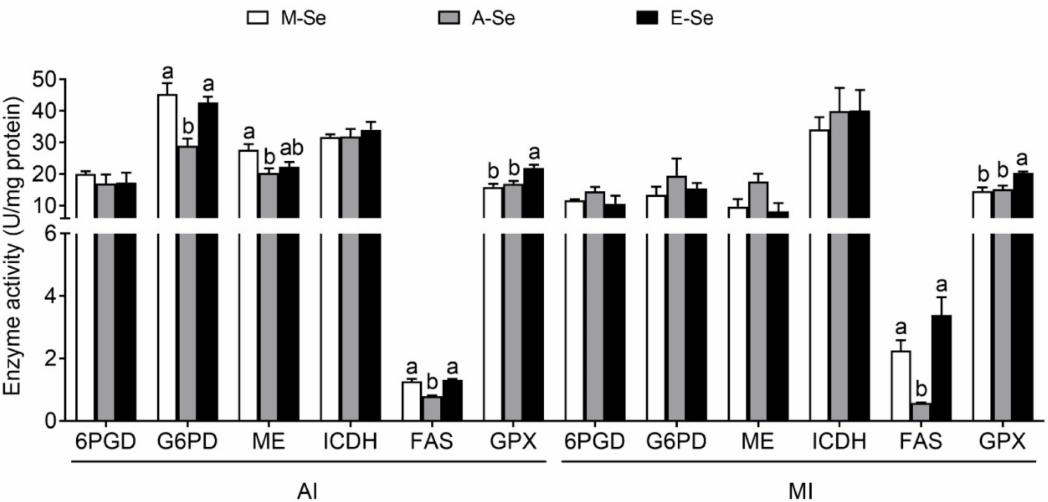
Figure 4. Lipid metabolism-related enzymatic activities and GPX activities in the AI and MI of yellow catfish fed diets varying in Se level for 12 wk. Values are means ± SEMs, n = 3 (replicates of 3 fish). Labeled means without a common letter differ, p < 0.05 (one-factor ANOVA, Duncan post hoc test). 6PGD, 6-phosphogluconate dehydrogenase; AI, anterior intestine; FAS, fatty acid synthase; G6PD, glucose 6-phosphate dehydrogenase; GPX, glutathione peroxidase; ICDH, isocitrate dehydrogenase; ME, malic enzyme; MI, middle